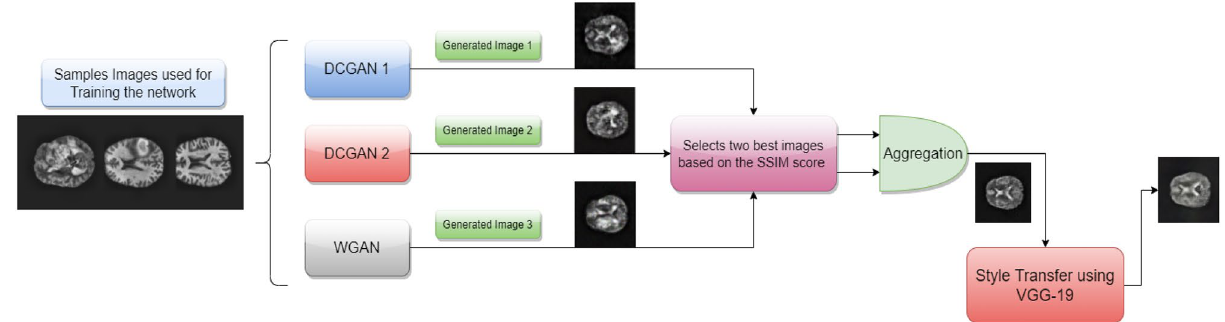
Figure 8. The working procedure of the proposed aggregation method (sample image source: BraTS 2020 dataset 16